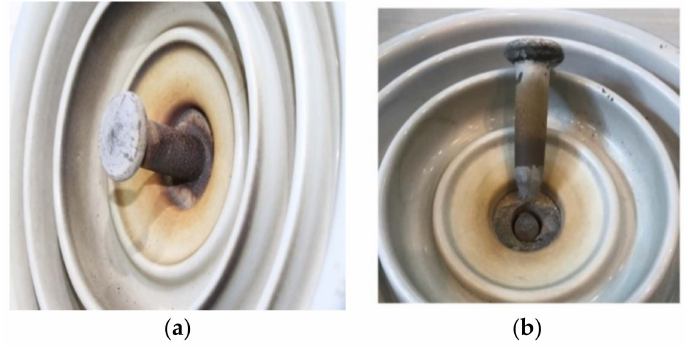
Figure 6. ( a ) Pin corrosion and ( b ) severe crevice corrosion.